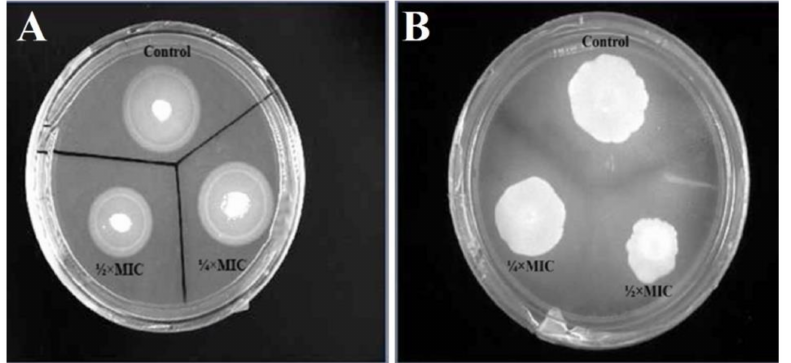
Figure 14. Representative plates of secretion of extracellular hydrolytic enzymes. ( A ) represents proteinase plate and ( B ) represents phospholipase. Untreated cells with turbid colonies surrounded by zone of protein degradation ( A ) and zone of lipid precipitation ( B ) serves as control, whereas other 2 zones represent cells exposed to 1 / 4 MIC and 1 / 2 MIC bimetallic Ag-Cu NPs.